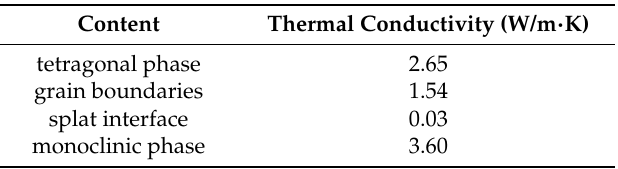
Table 2. The thermal conductivity input data.